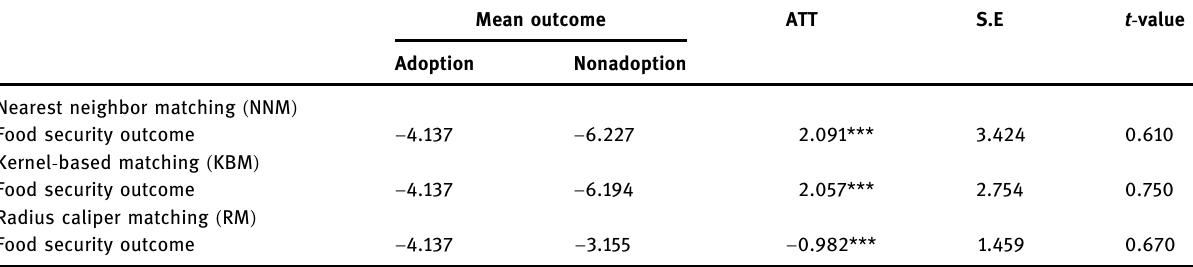
Table 8: Propensity score matching estimation